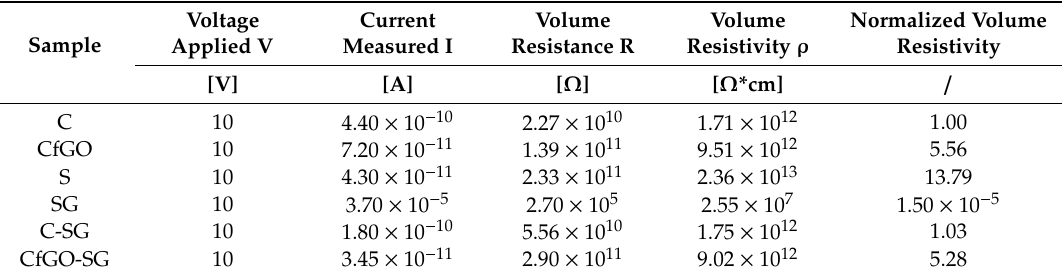
Table 5. Volume resistivity